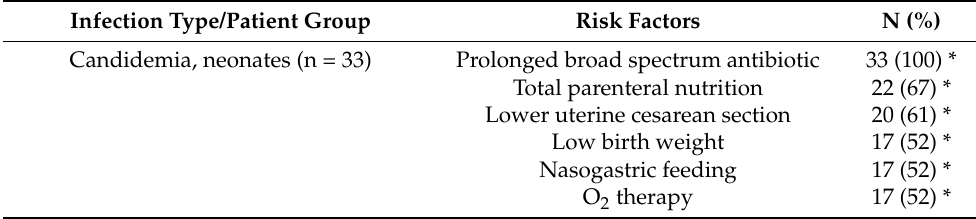
Table 4. Risk factors found among patients with individual candidal